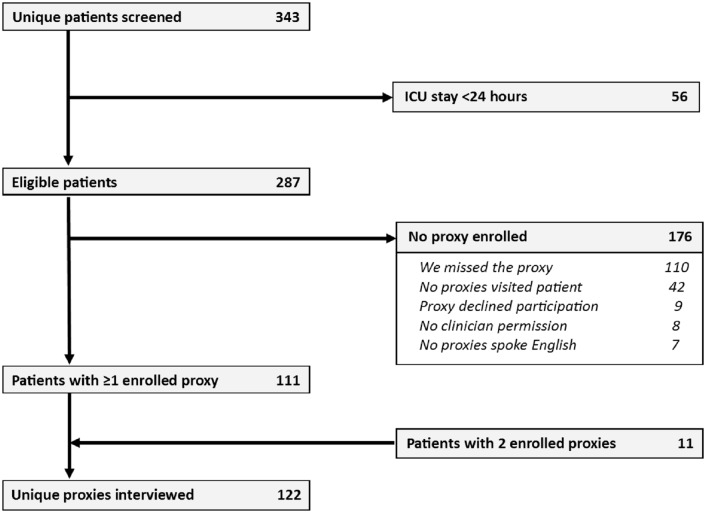
Study flow diagram.